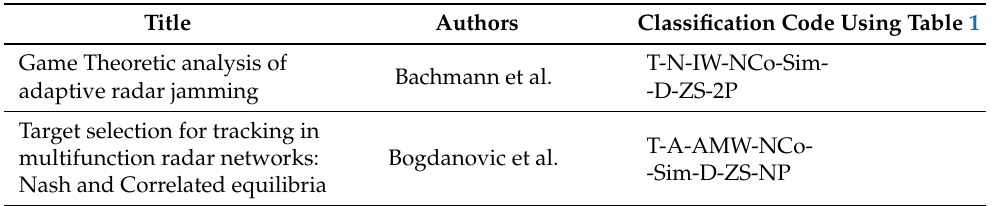
Table 2. Classification of papers in the niche of game-theoretic applications in defence, using Table 1. A total of 29 papers described here are